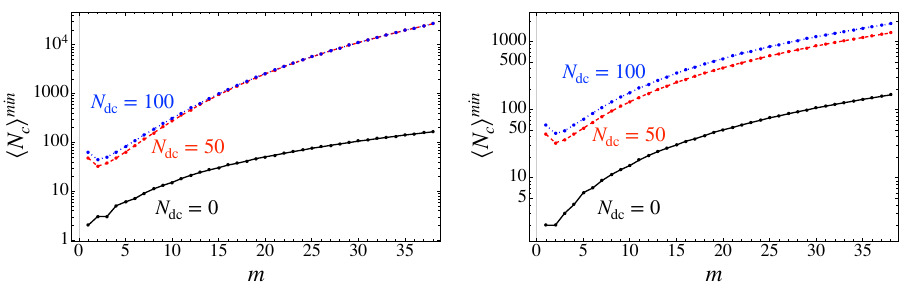
min such that Equation (13) ( left plot ) and N c (cid:104) (cid:105) min such that N c (cid:104) (cid:105)